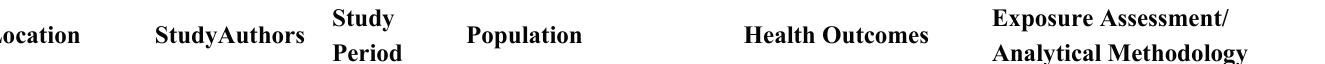
Table 2. Exposure to wildfire and cardiorespiratory